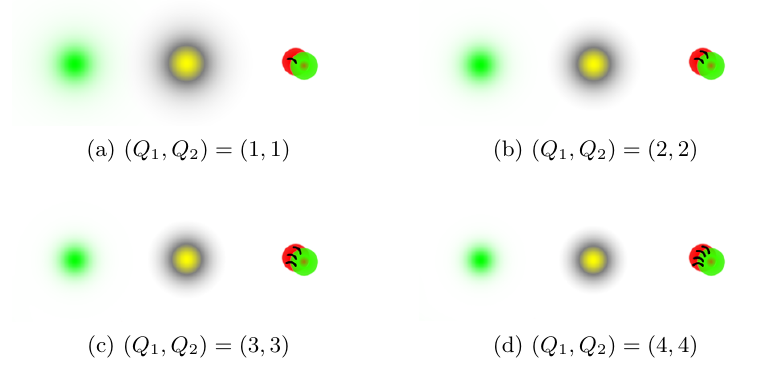
Figure 4 : Q 1 = Q 2 = Q minimal \normal" vortices with Q = 1 ; 2 ; 3 ; 4. Each sub(cid:12)gure contains 3 elements from left to right: an energy density plot, a (cid:12)eld density plot and a sketch of how the red and green vortices are interconnected. The (cid:12)rst two plots are made using the coloring scheme of (cid:12)gure